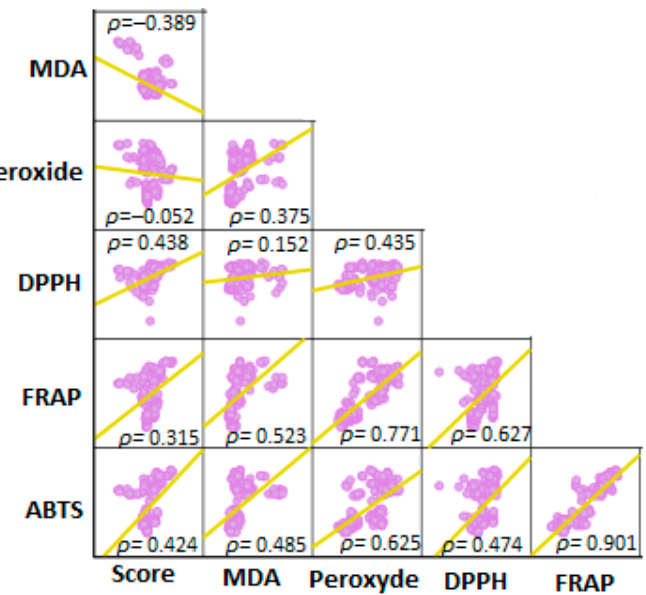
Figure 1. Correlation matrix showing Spearman correlation coefficients ( ρ ) between the pro- and antioxidant measurements and anti-pro-oxidant-score (all p -values < 0.001 except for the correlation between peroxides and anti-pro-oxidant score, which was not significant). Highest correlation was between FRAP and ABTS ( ρ = 0.901). All values are in logarithmic form.